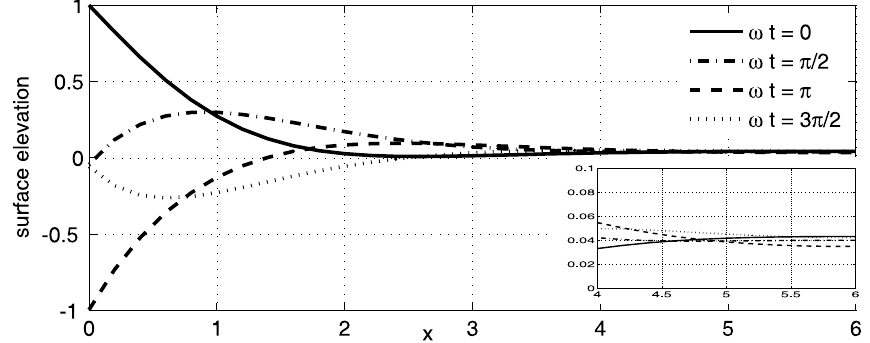
Fig. 3. Monochromatic waves enter the porous medium with four different scaled frequencies: ωt = 0, ωt = π/ 2, ωt = π , ωt = 3 π/ 2, computed using ε = µ 2 = 0 . 3. All four cases show the rising of mean water level as x → ∞ .